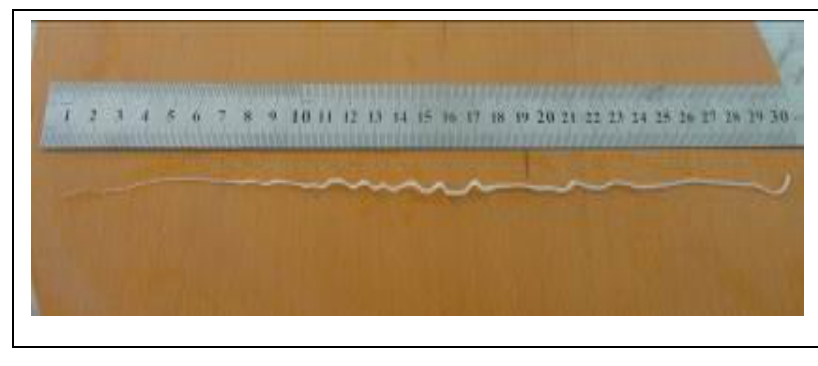
Figure, 3: Raillietina worm in pigeon